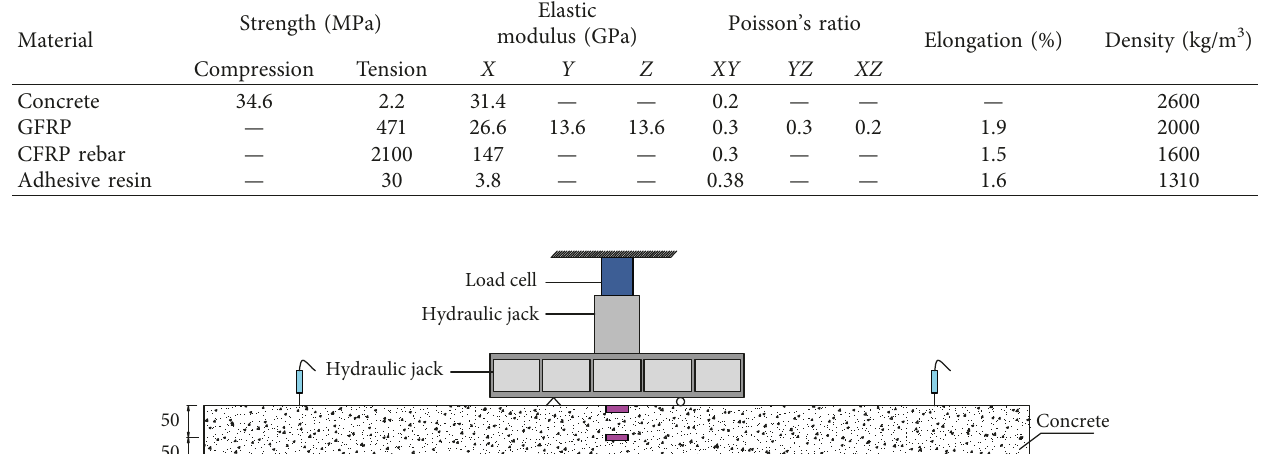
Table 2: Summary of material properties.